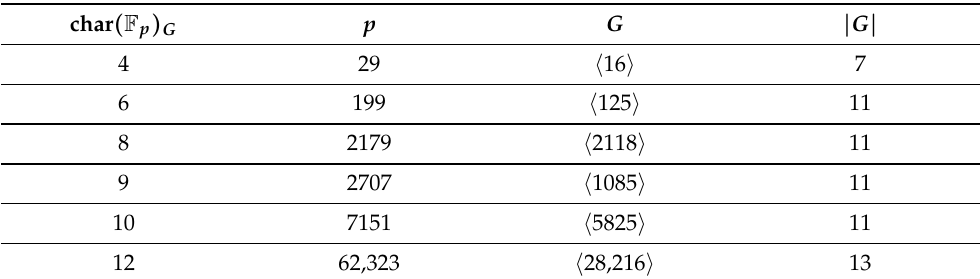
Table 1. Finite hyperfields of non-prime characteristic ≤